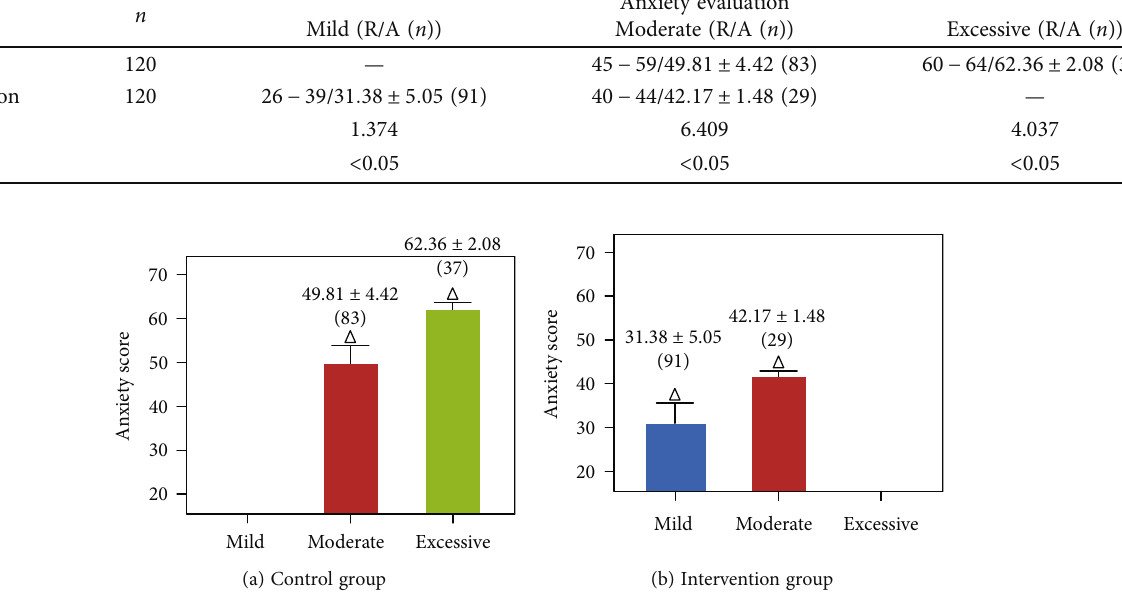
Figure 1: Anxiety evaluation results of college students in the control and intervention groups after treatment. Table 4: Comparison of anxiety evaluation results of college students with di ff erent grades in the control and intervention groups before treatment (BT) and after treatment (AT) ( (cid:1) x ± s ). Note: R: range; A: average.